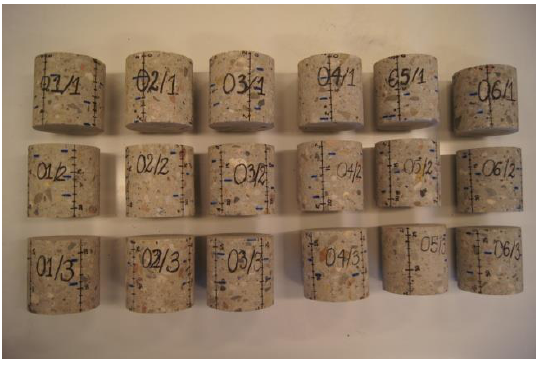
Figure 7. Core samples with height / diameter ratio h / d = 1, obtained from samples 01–06.